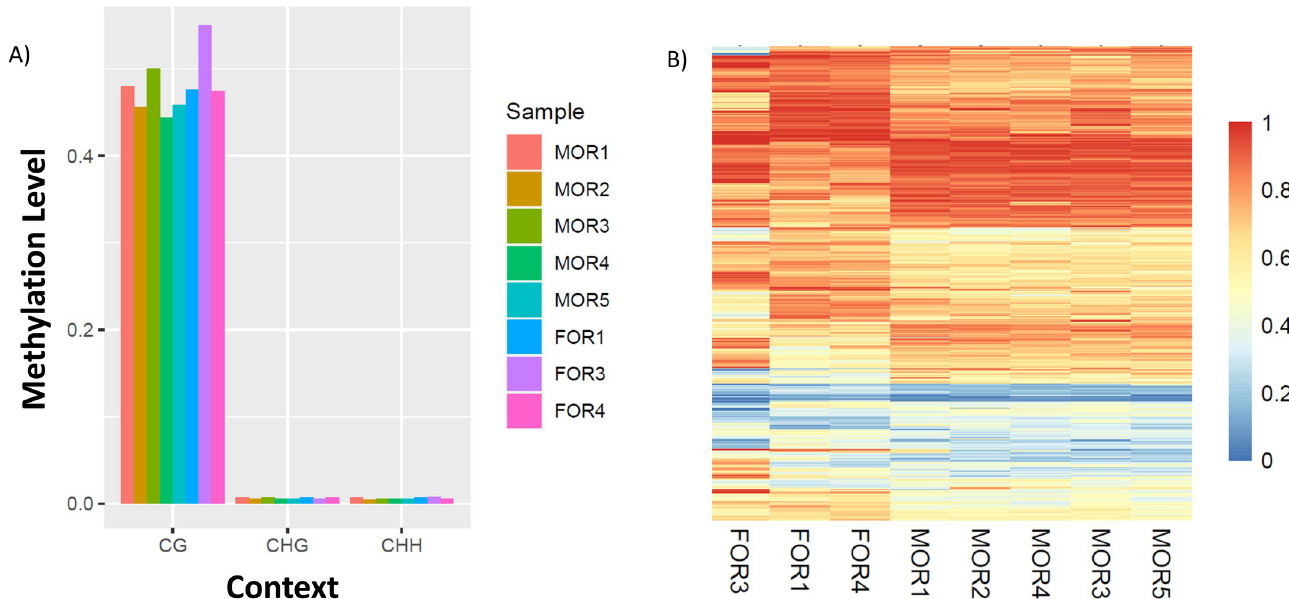
Fig 1. Distinct global CpG methylation pattern observed between contexts and conditions. A) Global Methylation levels show higher methylation of CG context: Average Global methylation levels of the eight samples (5 MORs, 3 FORs). CG methylation level is higher than the other contexts for all the samples. B) Heatmap of DMR methylation ratios for reads in the CpG context plotted against animal number shows differential methylation patterns between MORs and FORs. Higher value red, lower value blue. https://doi.org/10.1371/journal.pone.0263319.g001 the DMC’s located in intergenic regions and the least in the promoter region (Fig 2B and 2C,